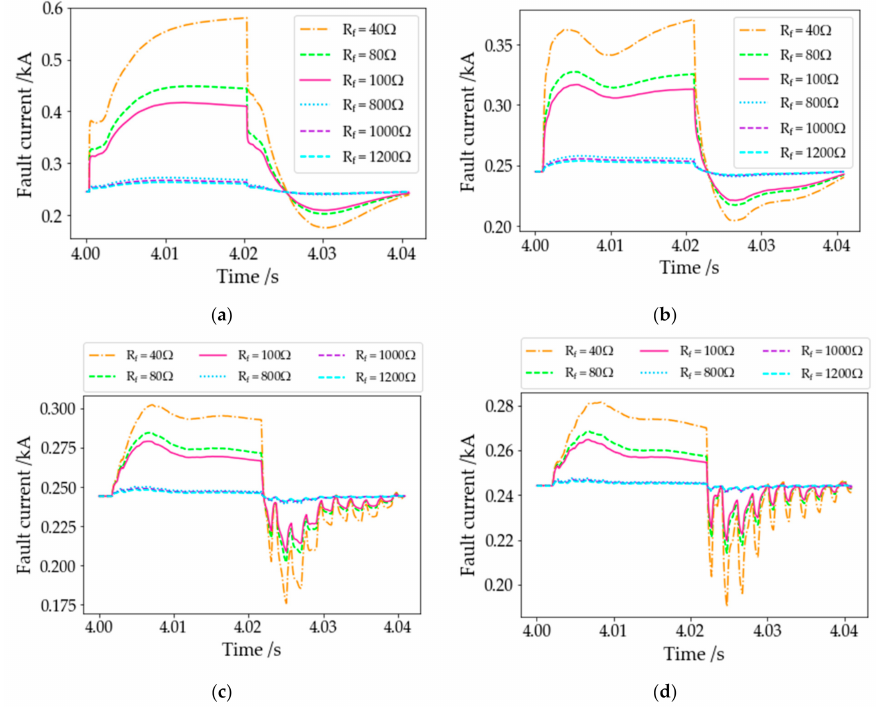
Figure 11. Fault current at M terminal when the transition resistance R f changes; ( a ) PG fault at 50 km, ( b ) PG fault at 150 km, ( c ) PG fault at 300 km, and ( d ) PG fault at 400